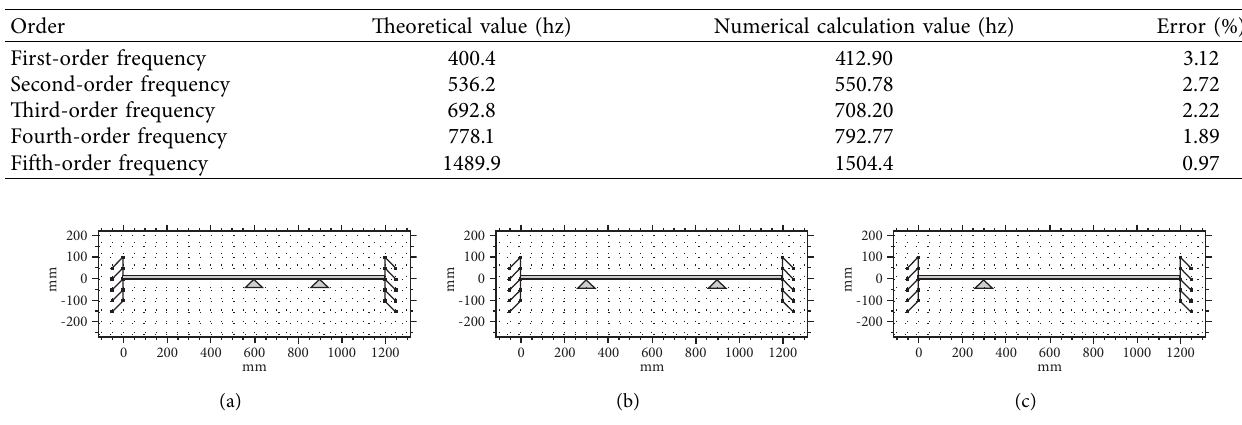
Table 3: Theoretical value and numerical calculation value for natural frequency of four-span tube.